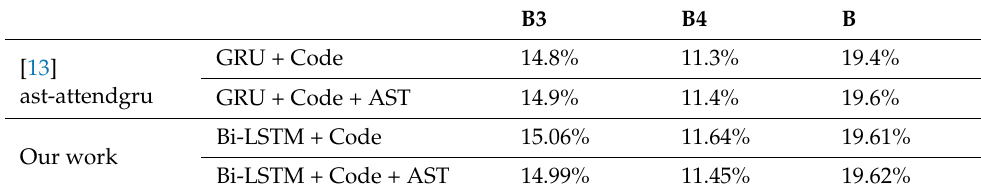
Table 3. Comparison with